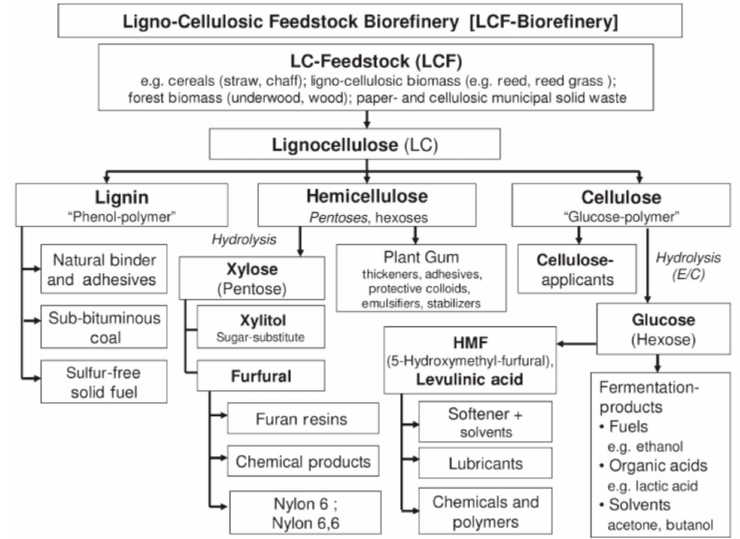
Figure 2. Products of a lignocellulosic feedstock biorefinery [7]. Copyright 2018 WILEY-VCH Verlag GmbH & Co. KGaA,